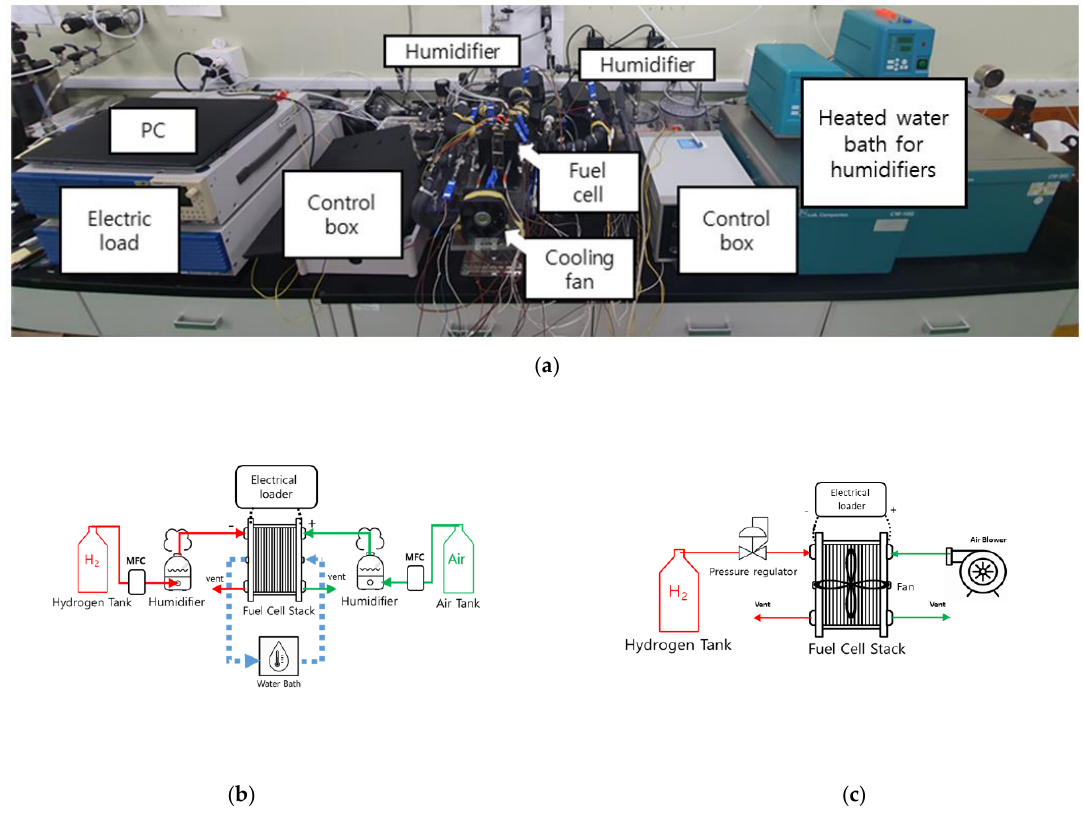
Figure 1. ( a ) Experimental setup for the performance test. ( b ) Schematic of flow-through operation. ( c ) Schematic of dead-ended operation.